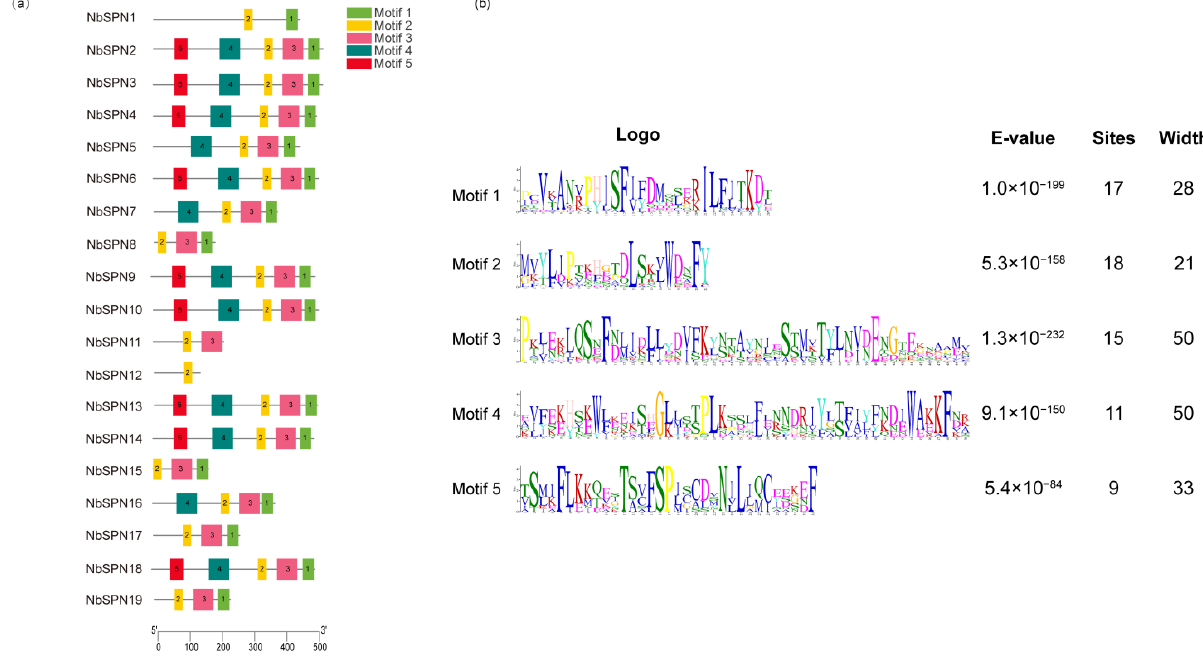
Figure 3. Conserved motifs of the NbSPN genes. ( a ) Distribution of conserved motifs in 19 NbSPNs, the differently colored boxes represent different bases, and the motif numbers are shown in the colored boxes. The scale represents the amino acid sequence length. ( b ) The features of the five conserved motifs among the NbSPN